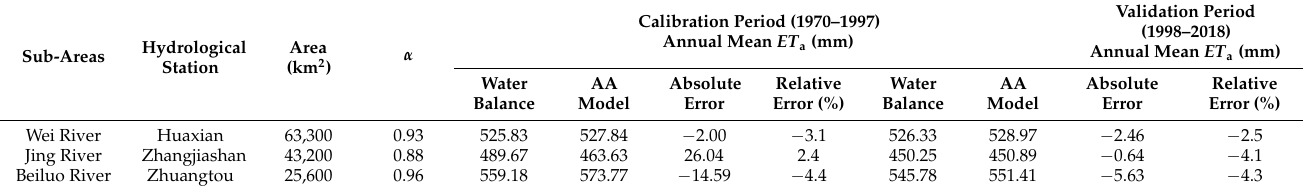
Table 4. The Advection–Aridity (AA) model calibration results in the Weihe River Basin.